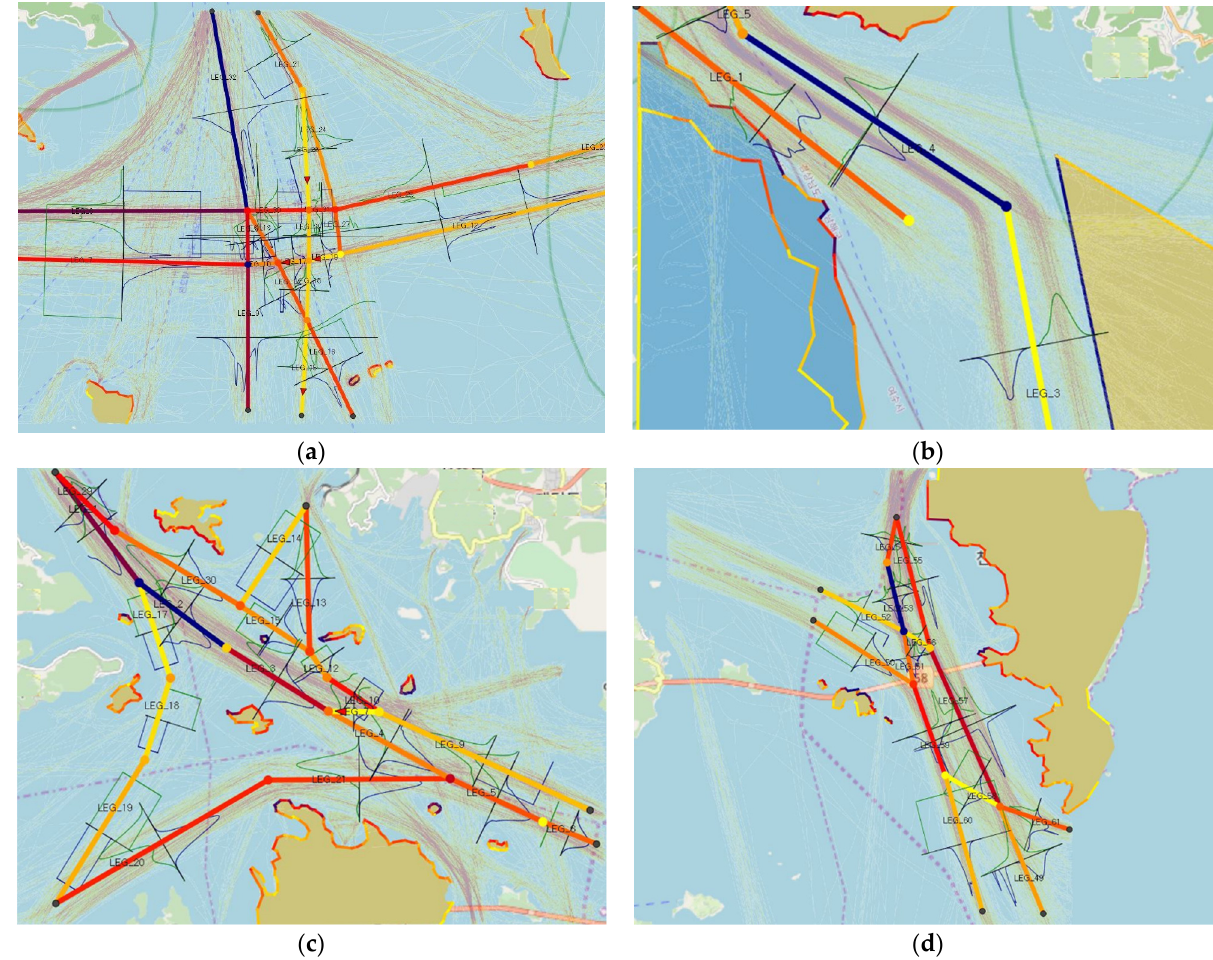
Figure 10. ( a ) Grounding frequency estimation results for the Wando fairway, ( b ) the Yeosu fairway, ( c ) the Masan fairway, and ( d ) the Gadeok fairway. ( c ) the Masan fairway, and ( d ) the Gadeok